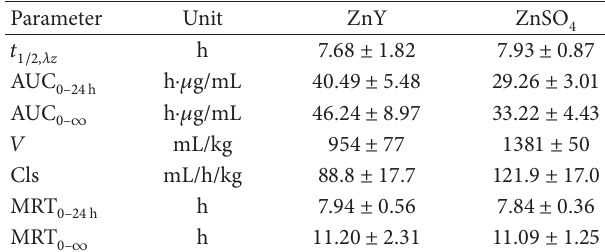
Table 1: The pharmacokinetic parameters of ZnY and ZnSO a single oral administration of Zn compounds at a dose level of 4 mg Zn/kg. Values are presented as mean ± SD ( 𝑛 = 3 ).